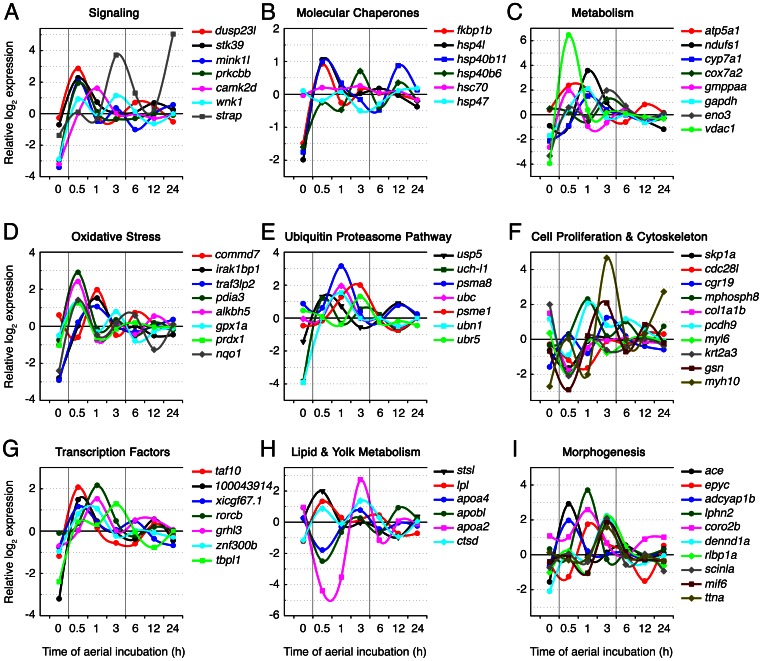
Time-course of log2 gene expression change on aerial incubation challenge in Fundulus heteroclitus embryos, partitioned by putative functional category.Representative genes of each category are shown. Log2 values at time 0 correspond to differences in expression in mid-gastrula embryos vs. 2–4 cells stage embryos. (A) wnk1, serine/threonine-protein kinase WNK1-like; strap, serine/threonine kinase receptor associated protein; dusp23l, novel protein similar to vertebrate dual specificity phosphatase 23; stk39, serine/threonine kinase 39, STE20/SPS1 yeast homolog; mink1l, novel protein similar to vertebrate misshapen-like kinase 1; prkcbb, protein kinase C beta 1; camk2d, calcium/calmodulin-dependent protein kinase type II delta chain. (B) fkbp1b, peptidyl-prolyl cis-trans isomerase; hsp4l, heat shock protein 4, like; hsp40b11, heat schok protein 40 B member 11; hsp40b6, DnaJ-like subfamily B member 6; hsc70, heat shock cognate 70; hsp47, heat shock protein 47. (C) atp5a1, ATP synthase subunit alpha; ndufs1, NADH dehydrogenase (ubiquinone) Fe-S protein 1, 75 kDa (NADH-coenzyme Q reductase); cyp7a1, cholesterol 7 alpha-hydroxylase; cox7a2, cytochrome c oxidase, subunit VIIa 2; gmppaa, mannose-1-phosphate guanyltransferase alpha-A; gapdh, glyceraldehyde 3-phosphate dehydrogenase; eno3, beta enolase; vdac1, voltage-dependent anion channel 1. (D) commd7, COMM domain-containing protein 7; irak1bp1, interleukin-1 receptor-associated kinase 1-binding protein 1; traf3lp2, TRAF3 interacting protein 2; pdia3, disulfide-isomerase A3; alkbh5, alkylation repair homolog 5; gpx1a, glutathione peroxidase; prdx1, peroxiredoxin 1; nqo1, NAD(P)H dehydrogenase quinone 1. (E) usp5, ubiquitin specific protease 5; uch-l1, ubiquitin C-terminal hydrolase; psma8, proteasome subunit alpha type; ubc, ubiquitin carrier protein; psme1, proteasome activator complex subunit 1; ubn1, ubinuclein 1; ubr5, ubiquitin protein ligase E3 component n-recognin 5. (F) skp1a, S-phase kinase-associated protein 1A; cdc28l, novel protein similar to vertebrate CDC28 protein kinase family; cgr19, novel protein similar to rodent cell growth regulator with RING finger domain 1; mphosph8, M-phase phosphoprotein 8; col1a1b, collagen type I alpha 3 chain; pcdh9, protocadherin-9; myl6, Myosin light polypeptide 6; krt2a3, Type II keratin E3; gsn, Gelsolin; myh10, Myosin 10. (G) taf10, transcription initiation factor TFIID subunit 10; 100043914, novel KRAB box and zinc finger, C2H2 type domain containing protein; xicgf67.1, gastrula zinc finger protein XlCGF67.1; rorcb, RORgamma-B; grhl3, Grainyhead-like protein 3 homolog; znf300b, zinc finger protein 300-B; tbpl1, TATA box-binding protein-like protein 1. (H) stsl, novel protein similar to human steroid sulfatase (microsomal); lpl, lipoprotein lipase; apoa4, apolipoprotein A-IV; apobl, novel protein similar to vertebrate apolipoprotein B; apoa2, apolipoprotein A2; ctsd, cathepsin D. (I) ace, Angiotensin I converting enzyme; epyc, Epiphycan; adcyap1b, growth hormone releasing hormone/pituitary adenylate cyclase- activating; lphn2, Latrophilin 2; coro2b, Coronin-2; dennd1a, DENN domain-containing protein 1A; rlbp1a, cellular retinaldehyde-binding protein a; scinla, Gelsolin; mif6, myogenic factor 6; ttna, novel protein similar to human titin.